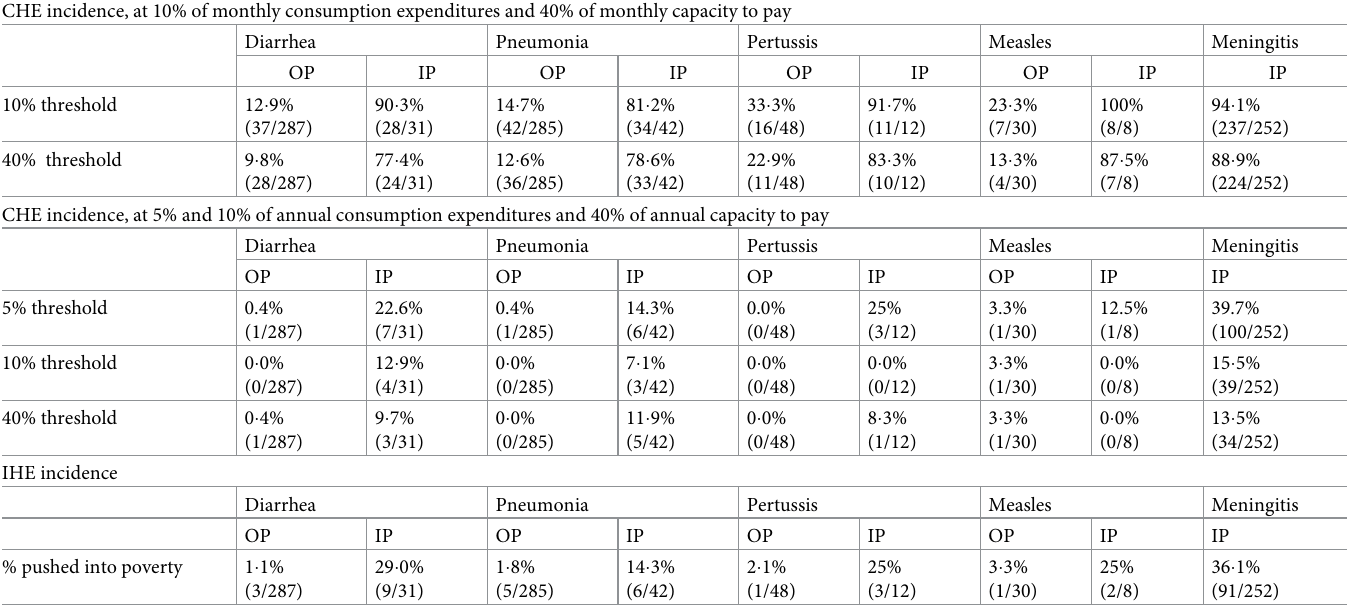
Table 4. Estimated incidence of CHEs and IHEs by disease